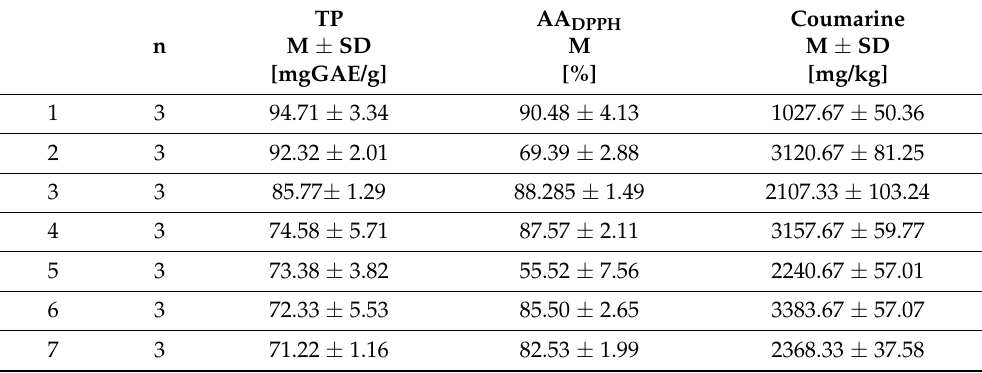
Table 6. Antioxidant activity (TP, AA) and coumarine content in cinnamon Cinamomum